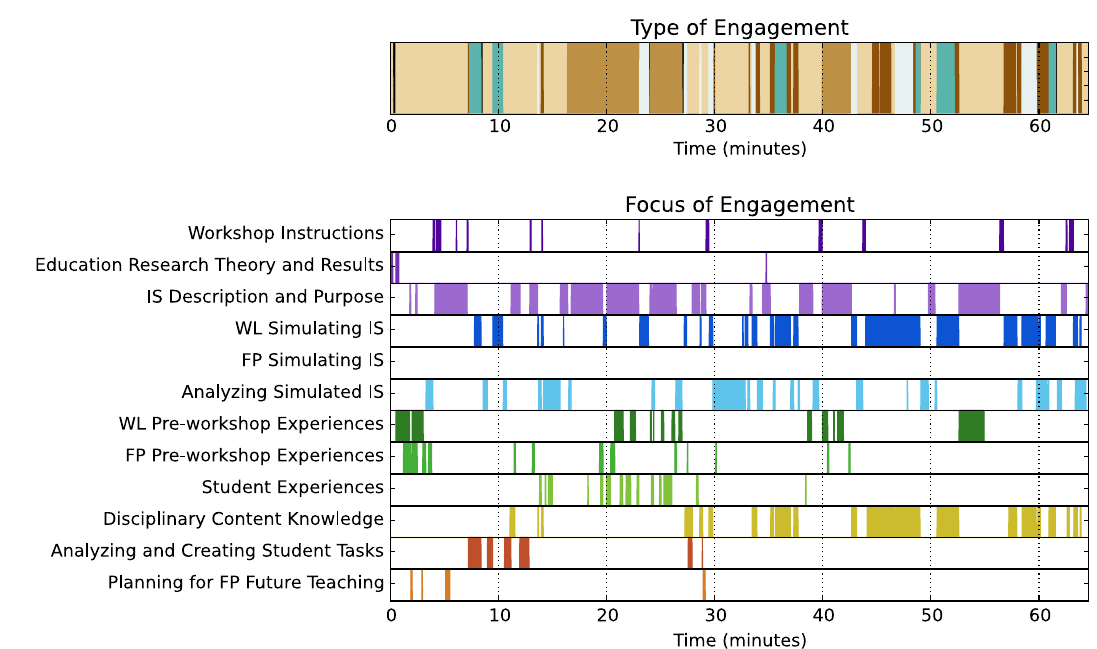
FIG. 3. Time line representations of the R-PDOT data for session B , showing how the type (top) and focus (bottom) of faculty ’ s engagement shifted during the session. The colors are consistent with those in Figs. 1 and 2, where again, brown indicates authoritative communicative approaches and teal indicates dialogic communicative approaches for the type of engagement, and the focus-of- engagement colors indicate loose